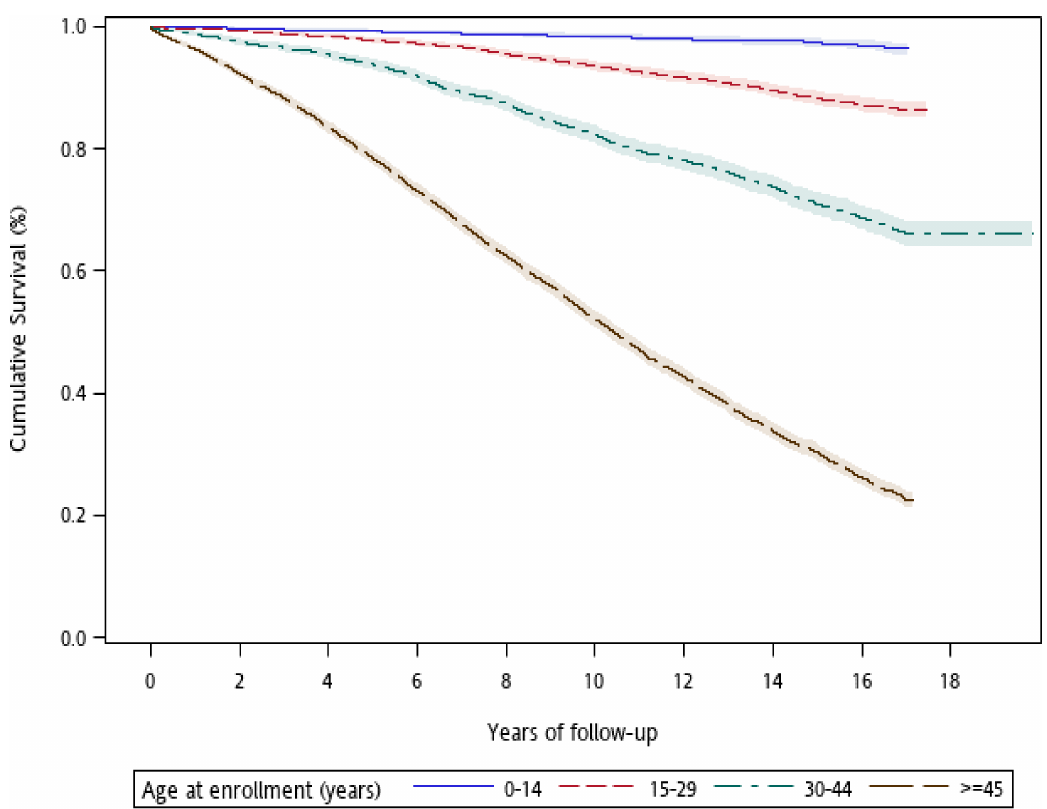
Figure 2. Age-speci fi c survival curves in patients with type 1